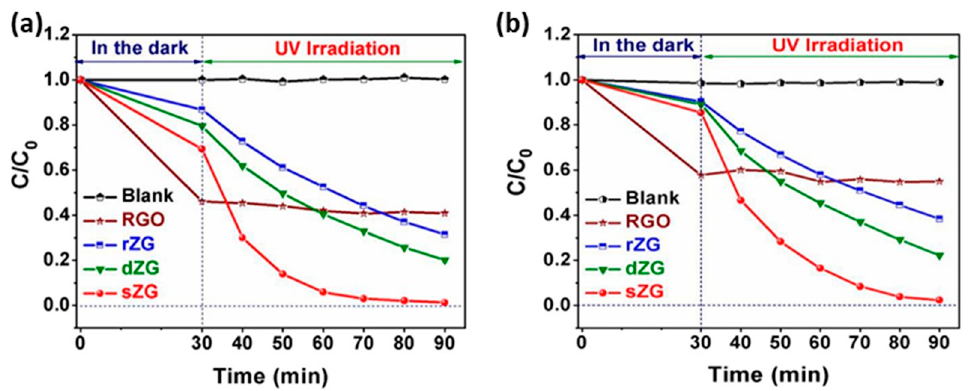
Figure 30. Photocatalytic degradation of a 10 mg L − 1 MB solution ( a ) and a 10 mg L − 1 RhB solution ( b ) under UV irradiation in the absence and presence of reduced graphene oxide (rGO), sZG, dZG, and rZG (0.1 g L − 1 ). Reprinted with permission from [159].